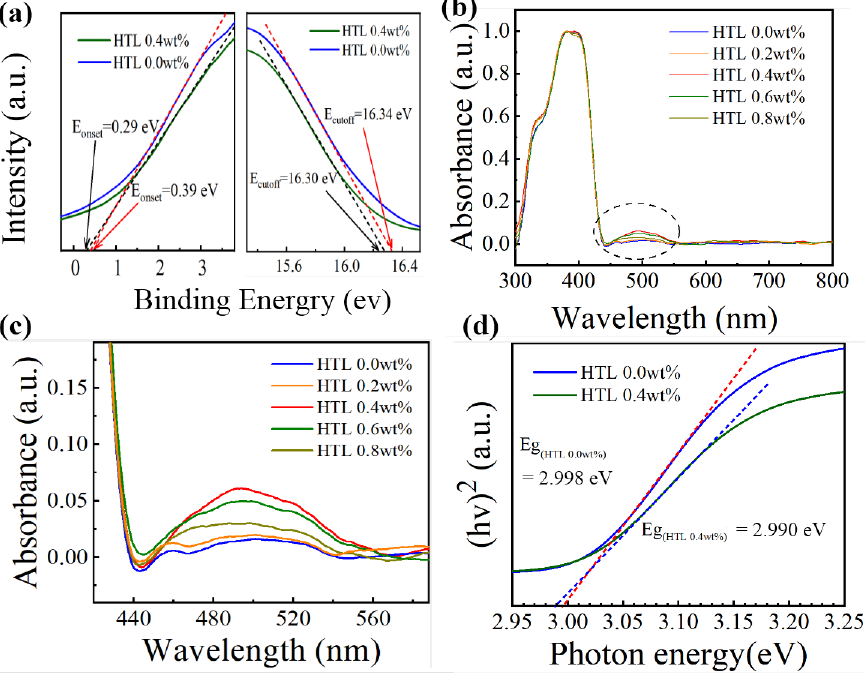
Figure 6. ( a ) UPS diagrams of HTL 0.0 wt% and HTL 0.4 wt% films: Eonset area (left), Ecutoff area (right). ( b ) Ultraviolet-visible absorption spectra of Spiro-OMeTAD doped with different CsI content. ( c ) magnified image of the oxidized Spiro-OMeTAD peak at 440–560 nm. ( d ) Tauc plots of the HTL 0.0 wt%t and HTL 0.4